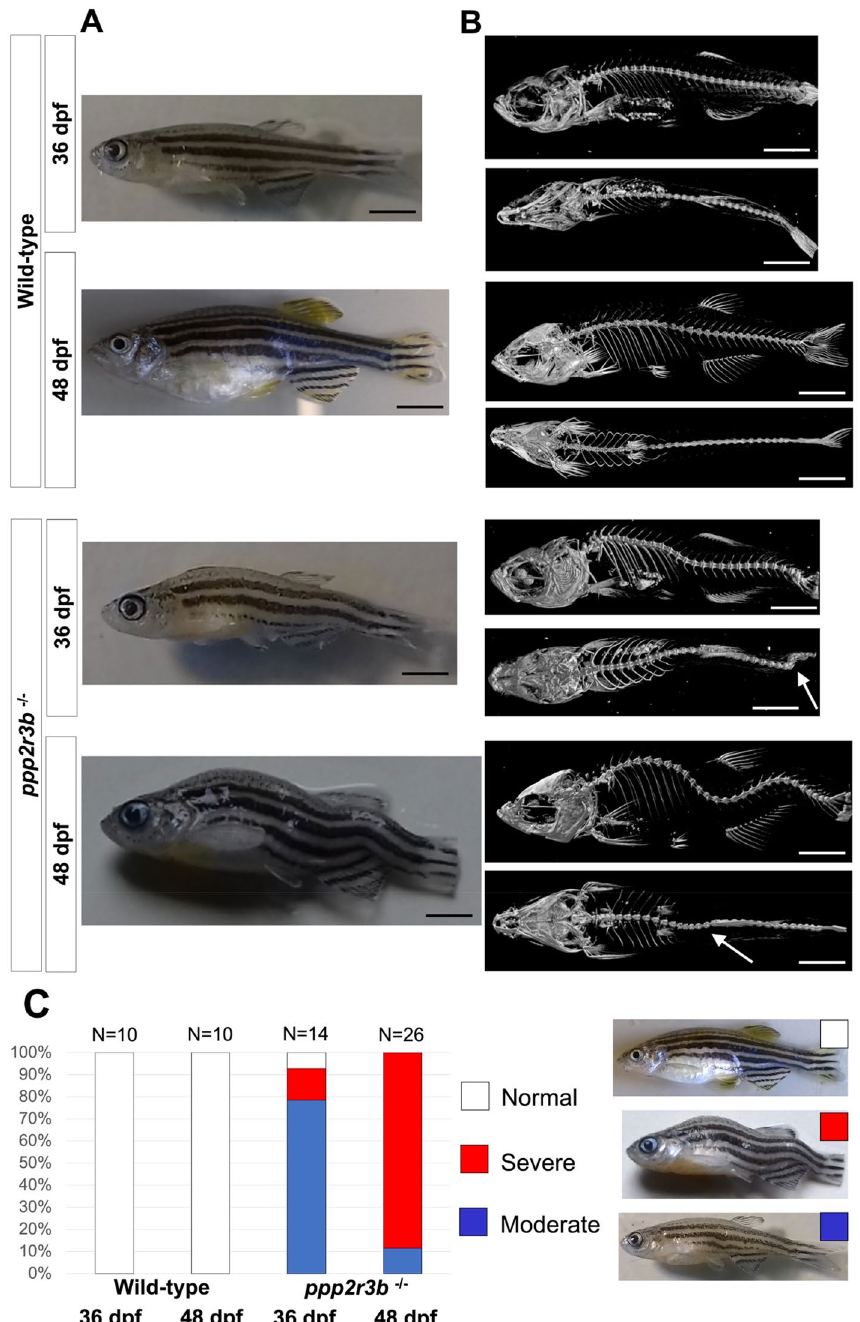
Figure 5. ( A ) Bright field images and ( B ) microCT scans of representative wild-type or homozygous ppp2r3b −/− mutant zebrafish at 36 or 48 dpf. White arrows in ( B ) point to sharp lateral curvatures of the spine. ( C ) Quantification of the proportion of animals with mild, moderate or severe kyphoscoliosis. Numbers of animals are given. Scale bars are 5 mm. All animals were generation